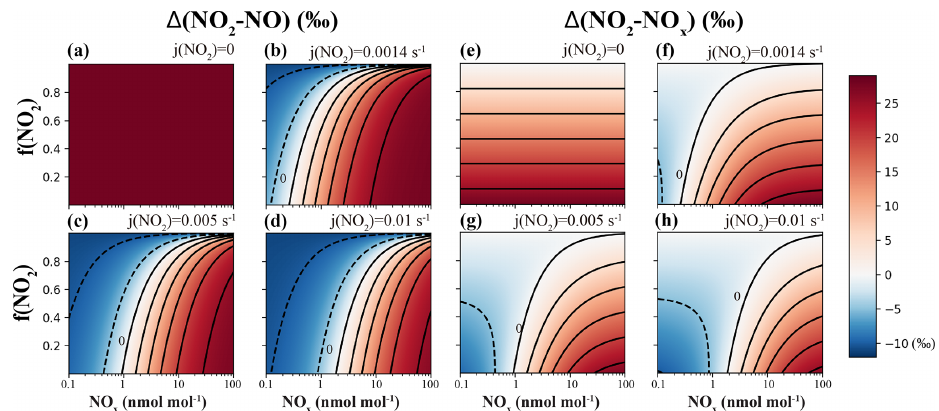
Figure 2. Calculating isotopic fractionation values between NO–NO 2 ( (cid:49) (NO 2 –NO); a–d ) and NO x –NO 2 ( (cid:49) (NO 2 –NO x ); e–h ) at various j (NO 2 ), NO x level and f (NO 2 ) using Eqs. (7) and (8). Each panel represents a fixed j (NO 2 ) value (on the upper-right side of each panel), and the fractionation values are shown by color. Lines are contours with the same fractionation values at an interval of 5‰; the contour line representing 0‰ was marked in each panel except for panels (a) and (e)